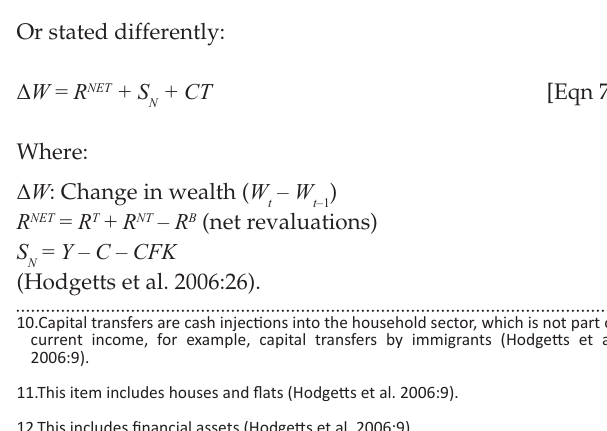
FIGURE 4: Household net wealth, 1995 to